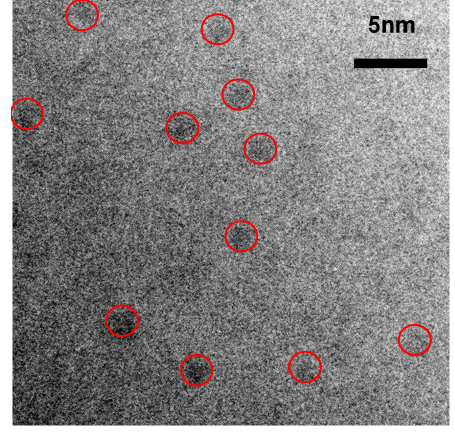
Figure 16. HRTEM micrograph of the D2 SiO x film. Figures 17 and 18 show the HRTEM micrographs of the D1’ fil., Figure 17 shows a large number of clusters with a diameter < 2 nm, while Figure 18 shows an enlarged micrograph showing certain regions with dimensions between 1 nm and 2 nm that show a certain crystalline orientation. To obtain the crystallographic orientation, the interplanar distances were measured. The micrographs shown in Figure 18 were analyzed using a Digital Micrograph program using Fourier transform to obtain the reciprocal space and thus be able to obtain the interplanar distances. With the interplanar distances, we proceeded to search the orientation of the nanocrystals by means of the crystallographic data provided by the database PDF 4. The presence of crystalline silicon with reference code 00-027- 1402 is appreciated.